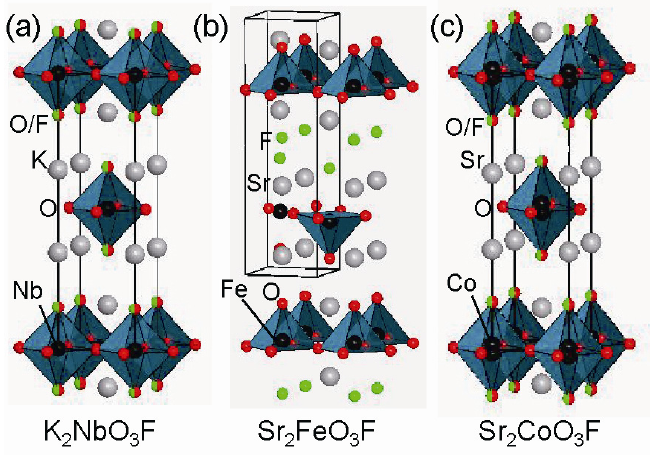
Figure 3. Crystal structure of ( a ) RbSrNb